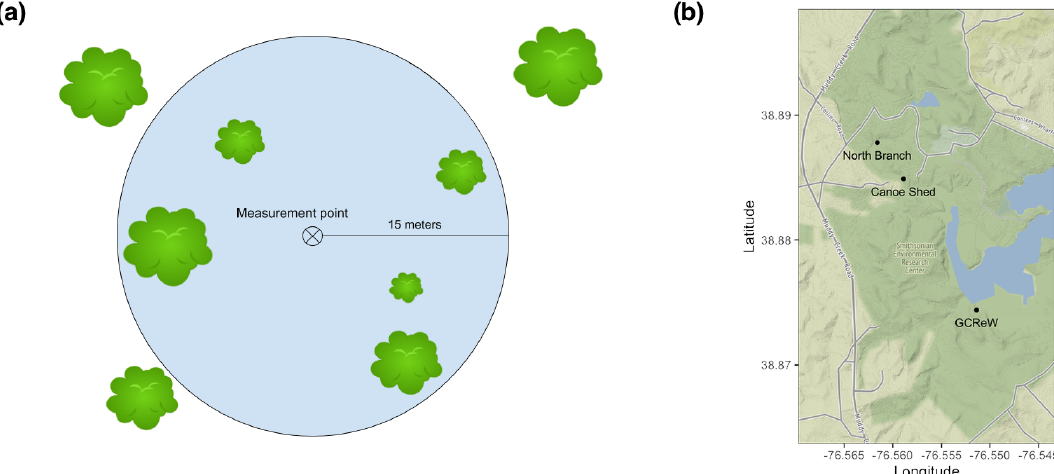
Figure 1. (a) Tree proximity measurement schematic. Distance to each tree was recorded within a 15m radius of each soil respiration measurement point, along with diameter at breast height (DBH) and species. (b) Map of the Smithsonian Environmental Research Center with the three sites labeled in black. (Map tiles by Stamen Design, under CC BY 3.0. Data by OpenStreetMap, under ODbL. © OpenStreetMap contributors 2019. Distributed under a Creative Commons BY-SA License.) Table 1. Study site characteristics of each site along Muddy Creek, including trees per hectare, cumulative basal area, main soil types, and dominant tree species by percent of basal area. Values are the mean ± standard deviation of N = 3800m 2 plots. Site Trees (ha − 1 ) BA (m 2 ha − 1 ) Dominant soil type Dominant tree Altitude species (by BA %) (m) Collington–Wist complex; Collington and Annapolis